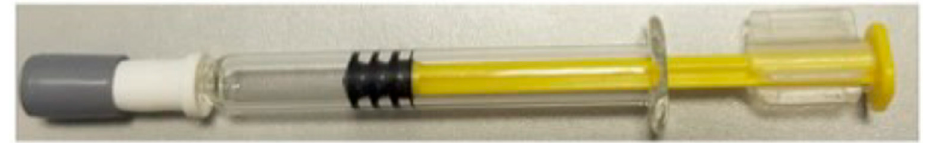
Figure 1. A sample of the intranasal DelNS1-nCoV-RBD LAIV .